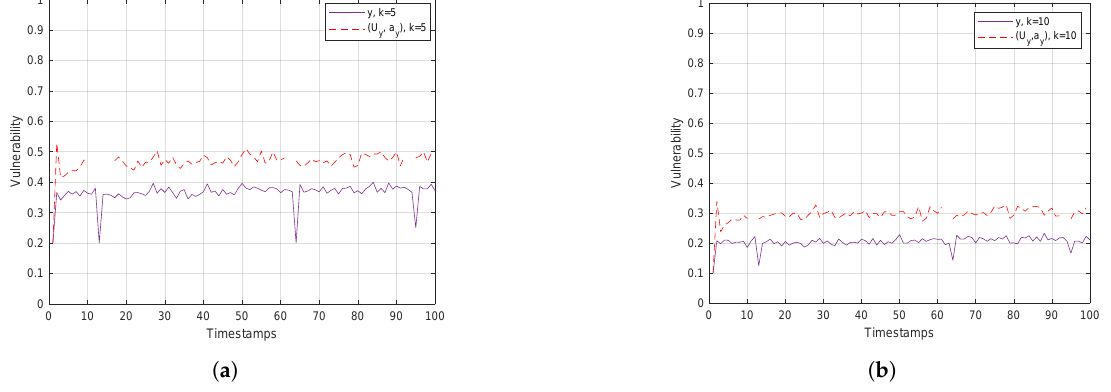
Figure 11. Hough- X Space of y for ( a ) k = 5 and ( b ) k = 10 for N = 500 Trajectories, L = 100